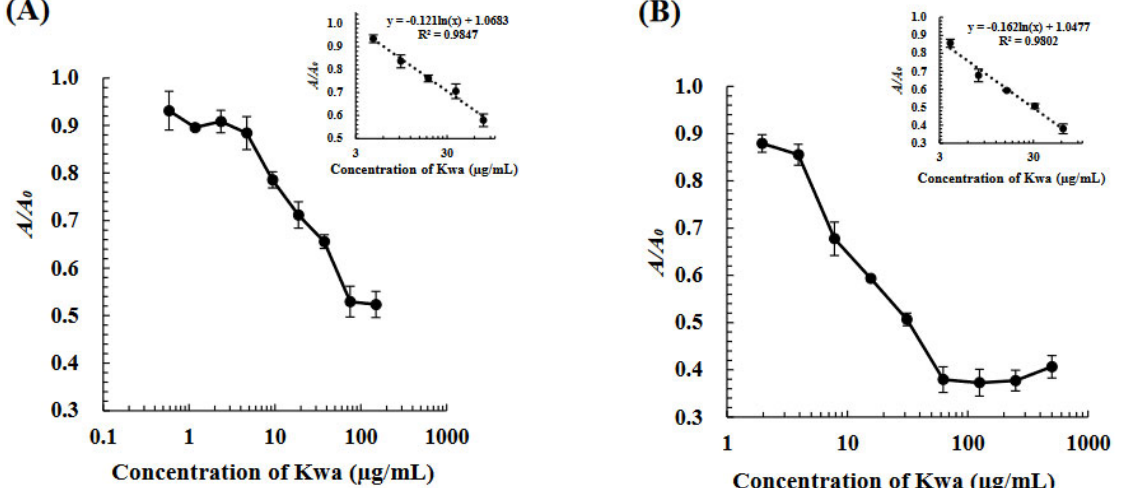
Figure 5. Calibration curves of ( A ) the icELISA and ( B ) cELBIA using biOVA. In icELISA, Kwa-HSA conjugates and biOVA were used at 2 and 200 µ g/mL, respectively. In cELBIA, Kwa-HRP conjugates and biOVA were used at 50 and 300 µ g/mL, respectively.